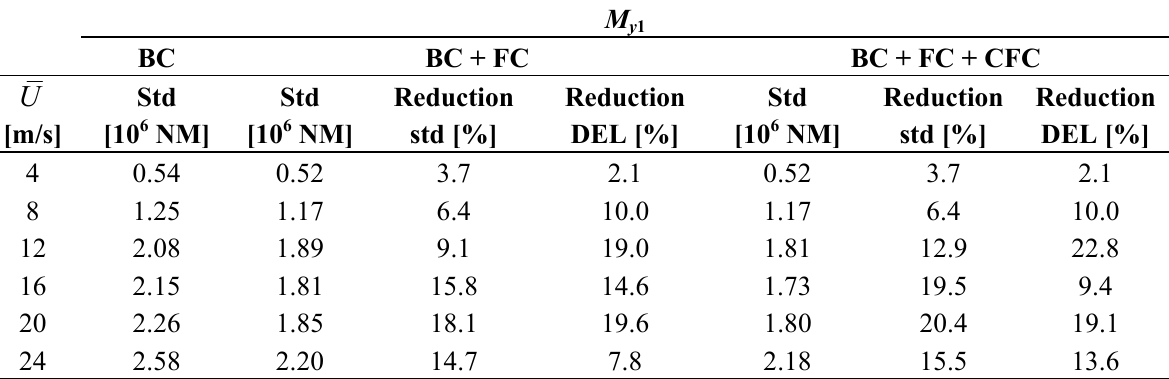
and B for NTM y 1 Td 1